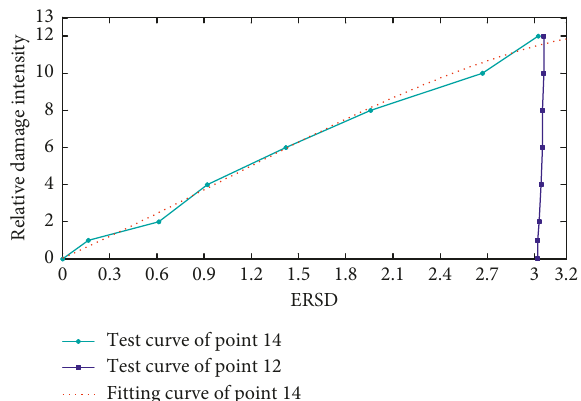
Figure 17: Curves of damage intensity and damage index in model tests (two damages).